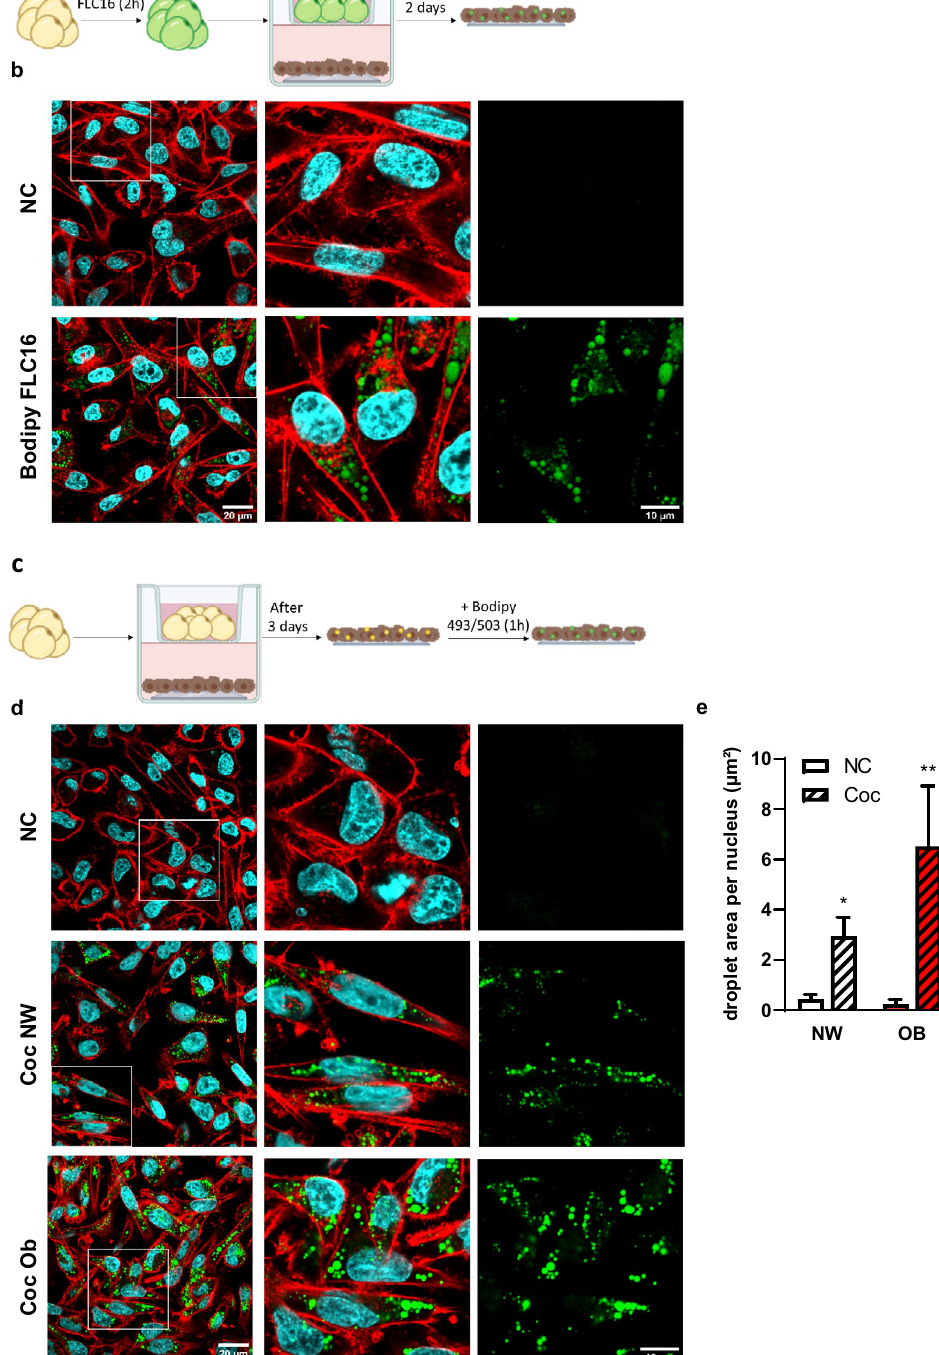
Figure 5. The transfer of FFA between adipocytes and BC cells is increased in obesity. ( a ) Experimental design: Isolated adipocytes (in yellow) were loaded for 2 h with BODIPY FLC 16 (in green) and cocultured with cancer cells (in brown) for 2 days. ( b ) Representative images of MDA-MB-231 cells cocultured or not (NC) with M-Ads previously loaded with BODIPY FLC 16 (in green). Actin was labeled with rhodamine-phalloidin (red) and nuclei were labeled with DAPI (blue). The white box in left panels indicates a zoomed crop of this area that is presented in the middle panel. The right panel shows the staining for BODIPY FLC 16 alone. ( c ) Experimental design used for the 3D coculture followed by BODIPY® 493/503 staining. ( d ) Representative images of MDA-MB-231 cells cocultured or not (NC) for 3 days with adipocytes obtained from normal weight (Coc NW) or obese (Coc Ob) patients after staining with BODIPY® 493/503, (neutral lipids, green), rhodamine-phalloidin (actin, red) and DAPI (nuclei, blue). The white box in left panels indicates a zoomed crop of this area that is presented in the middle panels. The right panel shows the staining for BODIPY® 493/503 alone. ( e ) Quantification of the droplet area per nucleus using ImageJ software in MDA-MB-231 cells cocultured (Coc) or not (NC) for 3 days with adipocytes obtained from NW (n = 10) or obese (OB) patients (n = 4). The histogram represents mean ± SEM *P < 0.05, **P <